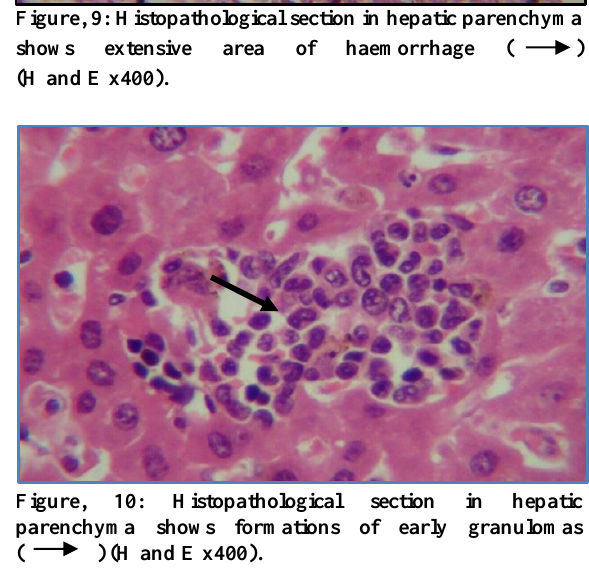
Figure, 9: Histopathological section in hepatic parenchyma shows extensive area of haemorrhage ( ) (H and E x400).